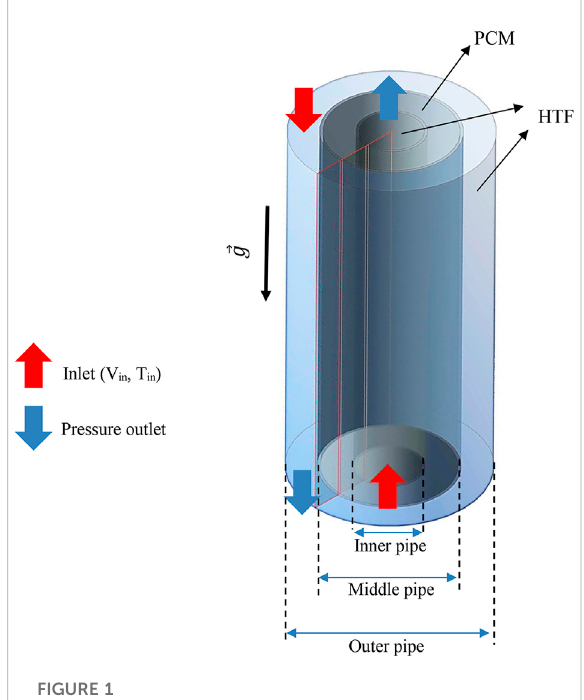
FIGURE 1 Schematicof a triplex-tube heat exchanger with no fi ns (case 0) proposed in this